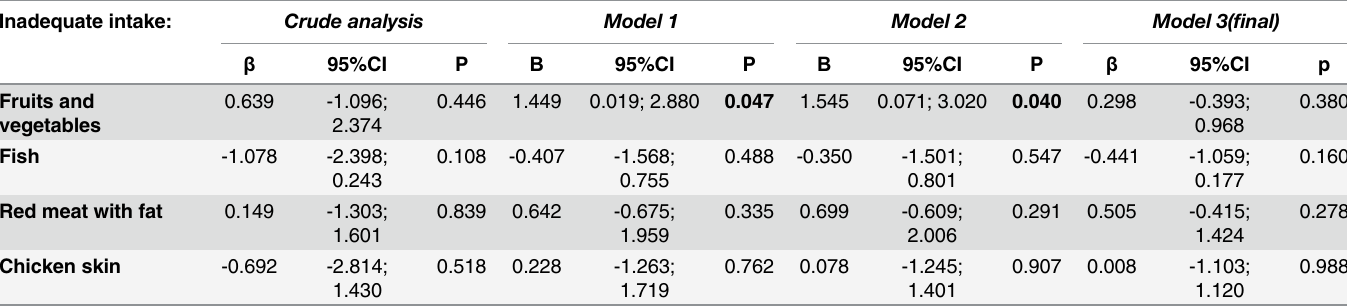
Table 3. Relationship between indicators of unhealthy food habits (inadequate food intake) and cognition in men. EpiFloripa Elderly , 2013/2014. Inadequate